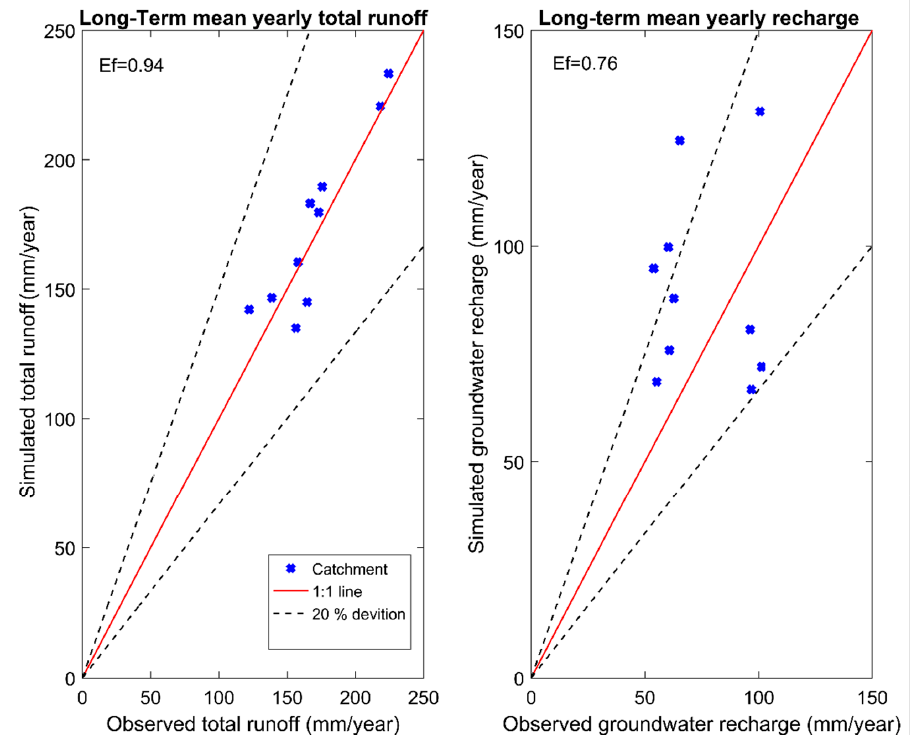
Figure 11. Comparison of the yearly long-term (observed-simulated) total runoff and groundwater recharge for the period 1991–2010 in ten subcatchments.